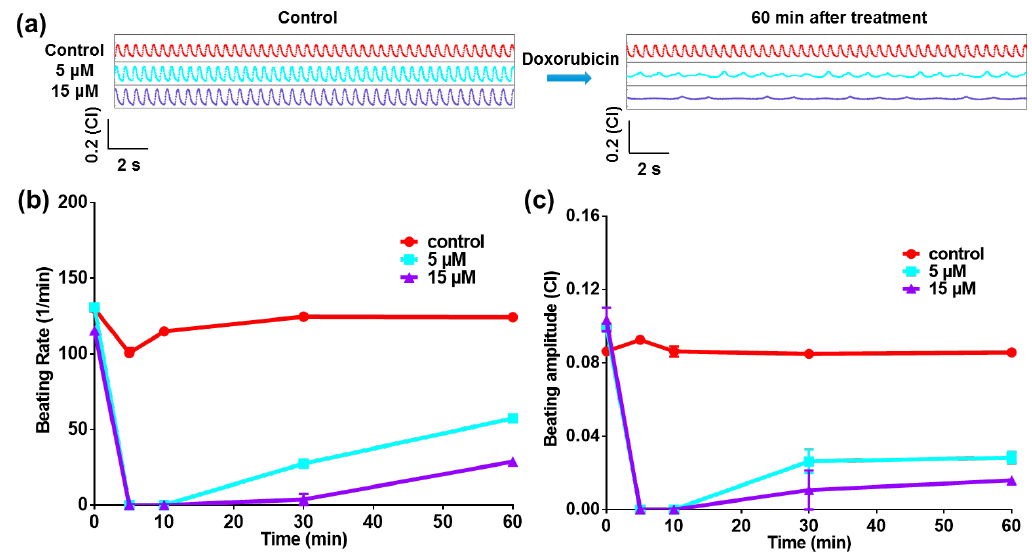
Figure 3. Heart-on-a-chip for doxorubicin test. ( a ) The beating signals before and after the doxorubicin with different concentrations are administered on the cardiomyocytes; ( b ) Statistical beating rate within 60 min in the presence of doxorubicin; ( c ) Statistical beating rate within 60 min in the presence of doxorubicin.